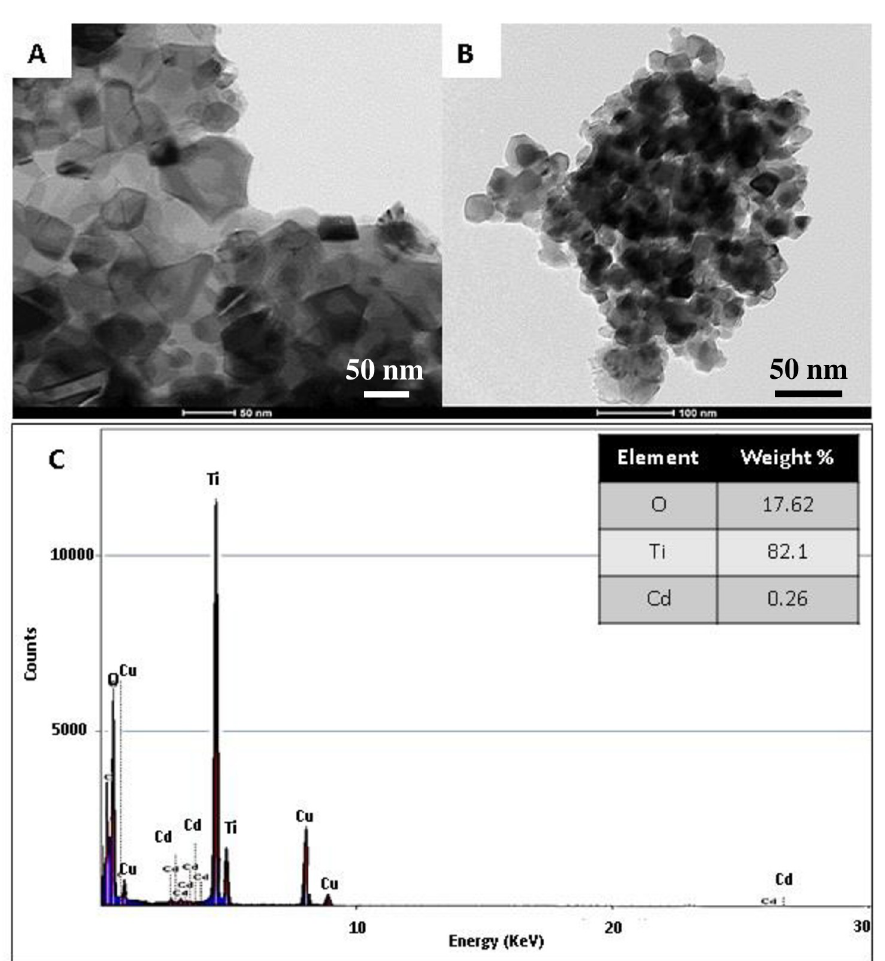
Fig 3. TEM images of pristine; (A) and CdO-doped; (B) TiO 2 nanoparticles. (C) The EDX image of CdTiO 3 doped TiO 2 nanoparticle obtained after atmospheric calcination at